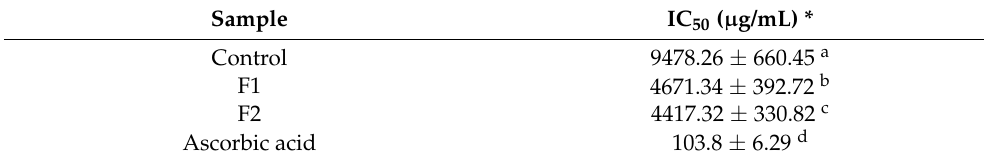
Table 4. IC 50 values of AGN and HME-AGN extracts against DPPH free radicals.